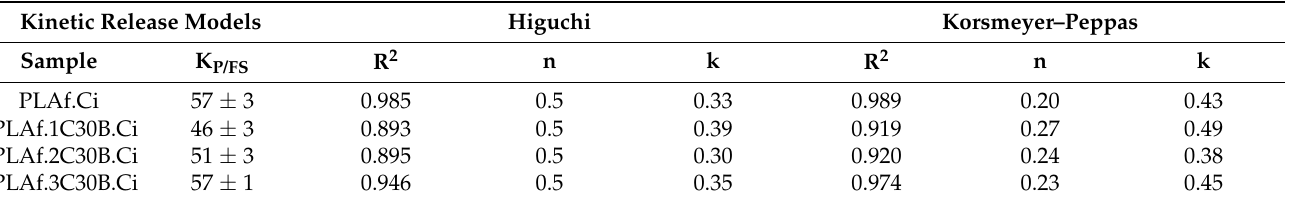
Table 3. Distribution coefficient (K P/FS ), regression coefficient (R 2 ), release rate constant (k), and the parameter n of the Korsmeyer–Peppas and Higuchi kinetic